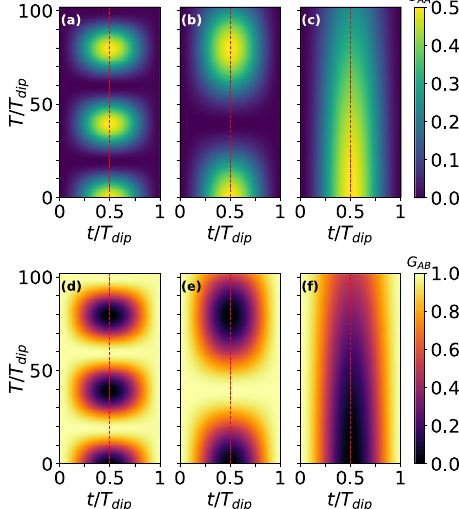
Fig. 7 Global correlations behavior in the analog Ramsey setup. Color scale plot showing the dependence of G AA (Eq. (25)) on both t / T dip and T / T dip , for a U k / J = 0.1, b U k / J = 0.05, and c U k / J = 0.01. Similarly, we also report the color scale plot with the dependence of G AB (Eq. (26)) on t / T dip and T / T dip , for d U k / J = 0.1, e U k / J = 0.05, and f U k / J = 0.01. Vertical lines have been added to each panel as a guide to the eye in evidencing the condition t / T dip =